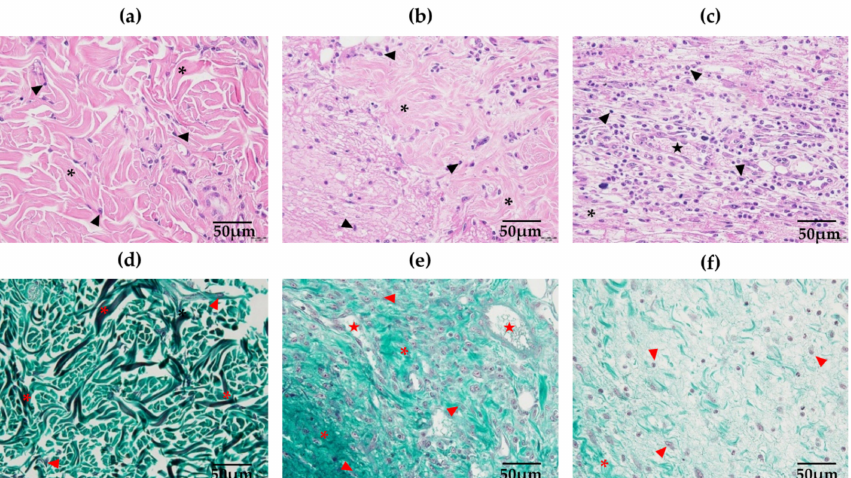
Figure 4. Photomicrographs in 40 × lens of the normal (unwounded region) ( a ), border ( b ) and center ( c ) regions of the wounds at the dermis in HE ( a – c ) and Mallory’s trichrome ( d – f ) stained samples. Arrowheads indicate the nucleus of cells that are abundant at the center of the wounds, which also presents a higher number of blood vessels indicated by a star; collagen fibers surrounding the cells are indicated by the asterisk, being well organized in the unwounded region of the skin and becoming more disorganized at the center of the wound. In the Mallory’s trichrome stained samples, abundant and organized collagen fibers (indicated as asterisks) are found at the unwounded region, being replaced by disorganized and shred fibers at the border and center. Bars 50 µ m.